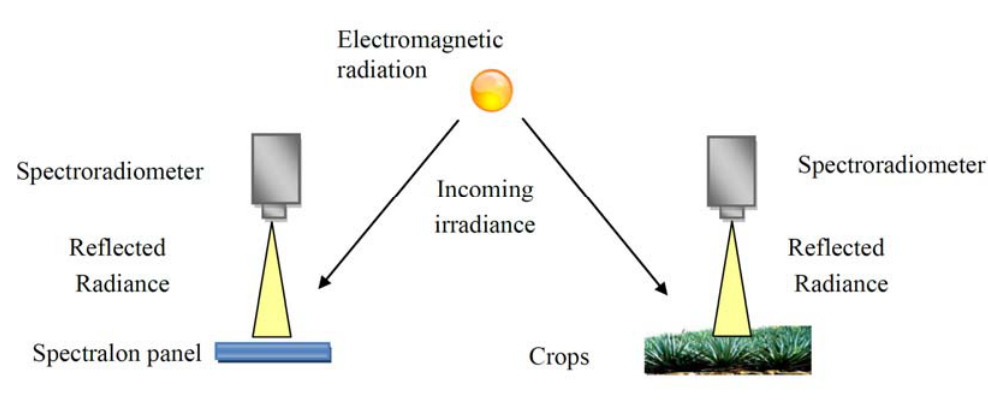
Figure 3. Methodology followed for the acquisition of ground spectroradiometric measurements. First, ( left ) the incoming radiance is estimated based on the reference measurement at a calibrated spectralon panel, and then, ( right ) the reflected radiance from the crops (“archaeological” and non archaeological areas) is also